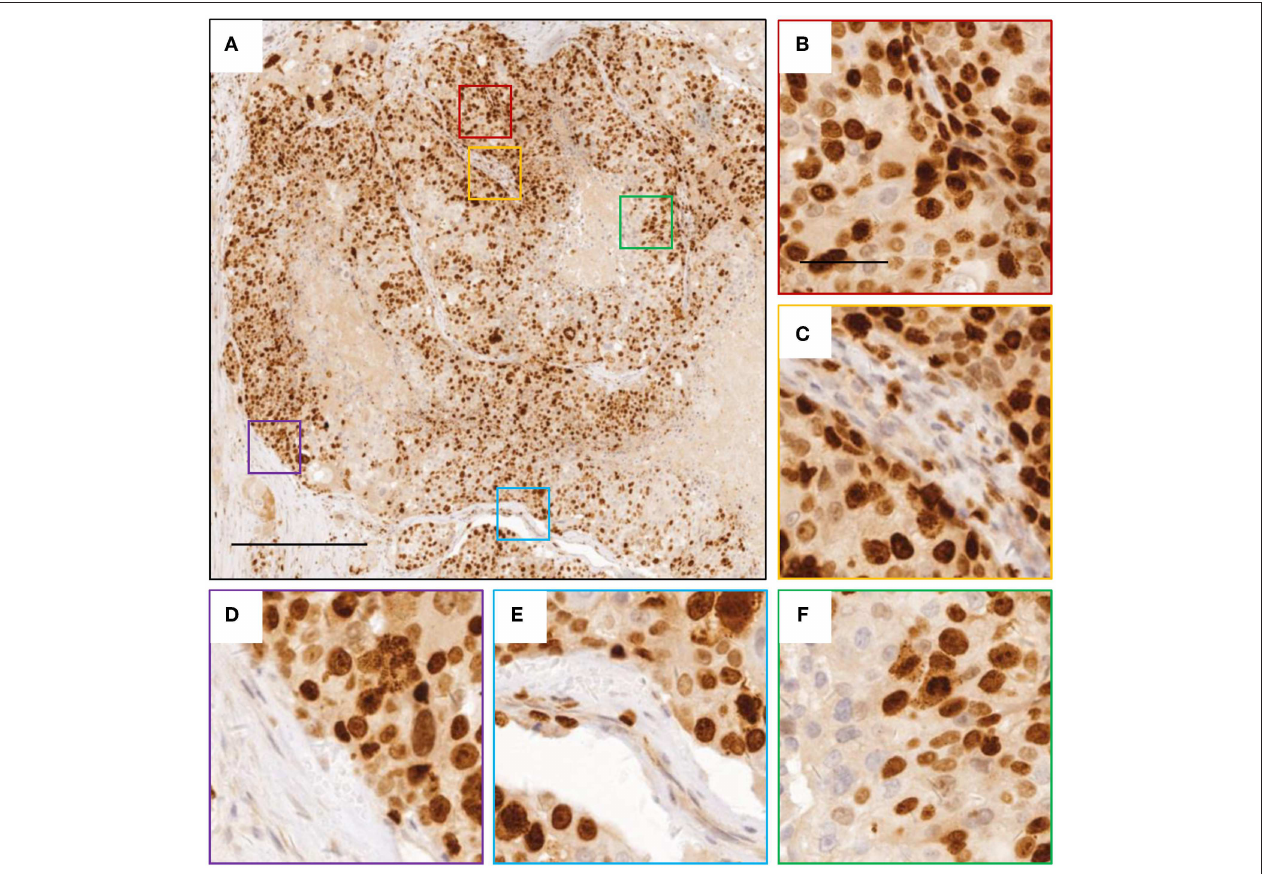
FIGURE 2 | Images of Ki-67 staining indicating active cell division. (A) representative image for breast cancer tissue with Ki-67 staining. (B–F) zoomed in images for boxed regions in (A) . The scale bars are 400 and 100 µ m,